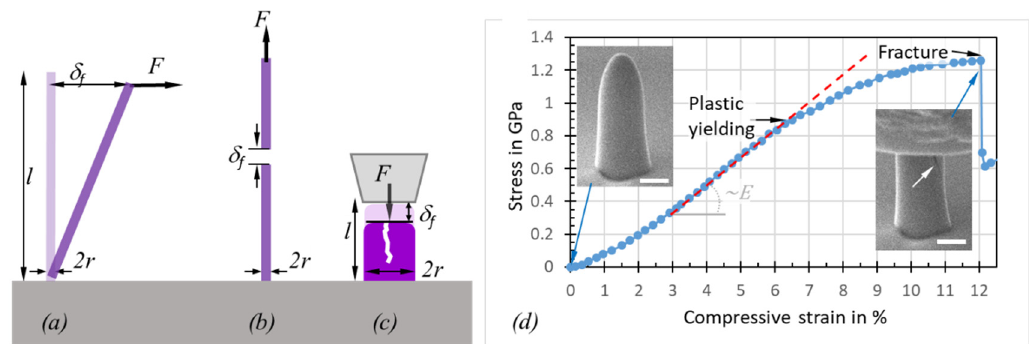
Figure 6. Approaches to measure the yield strength (plasticity) and the fracture strength of FEBID and FIBID materials. ( a ) Bending (one end pinned), ( b ) tensile straining, and ( c ) nanocompression with a flat blunt indenter. An example of a stress–strain diagram obtained from a nanocompression experiment with an FEBID pillar is shown in ( d ). Plasticity and fracture onsets are indicated by arrows; see also the crack propagating into the pillar. Circular cross-sections enable simple mathematics (see text); yet more complex 3D architectures can be also measured according to ( a )–( c ).